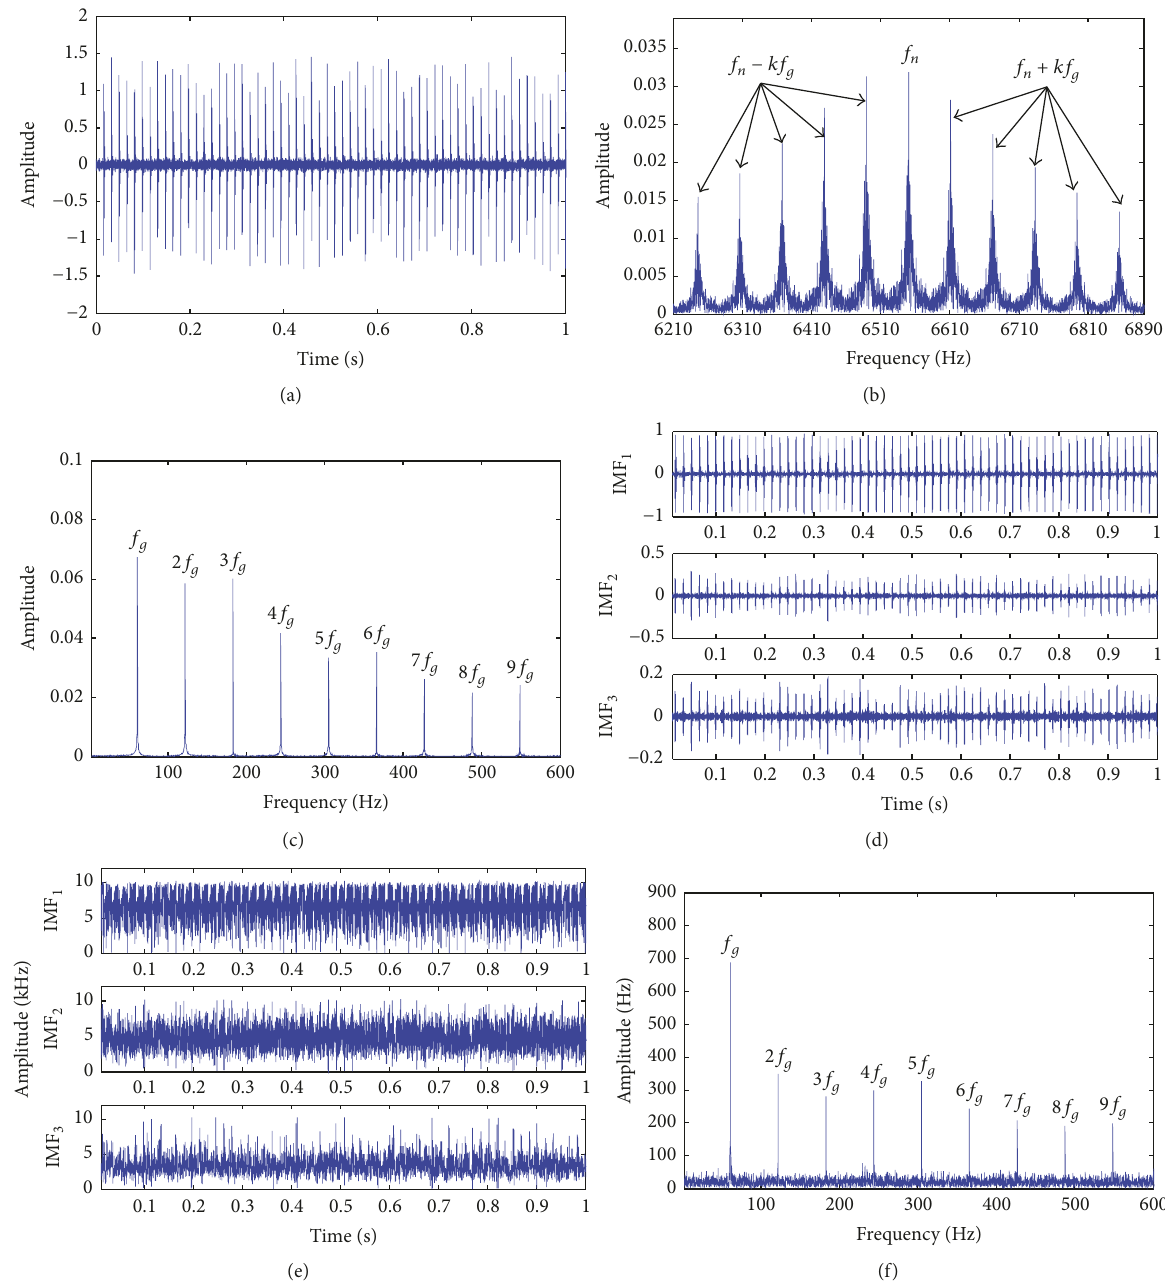
Figure 2: Simulated signal analysis: (a) signal waveform, (b) Fourier spectrum, (c) envelop spectrum, (d) IMFs, (e) instantaneous frequencies of IMFs, and (f) Fourier spectrum of instantaneous